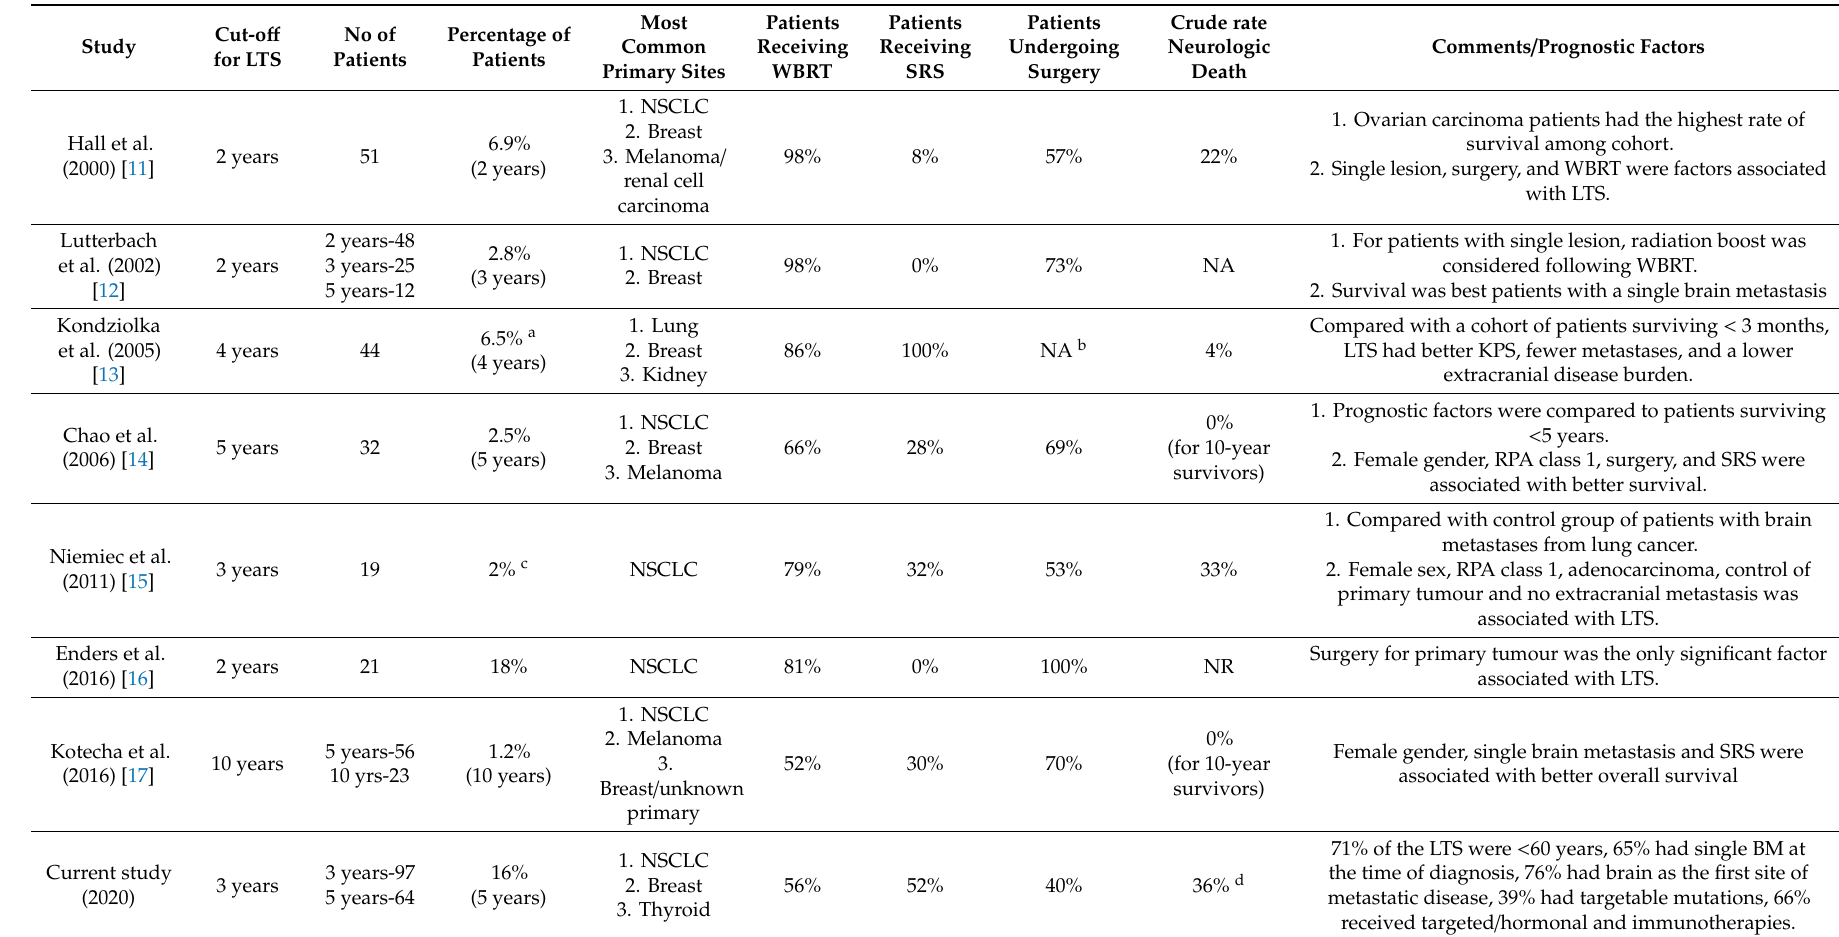
Table 4. Selected studies reporting long term survivors of brain